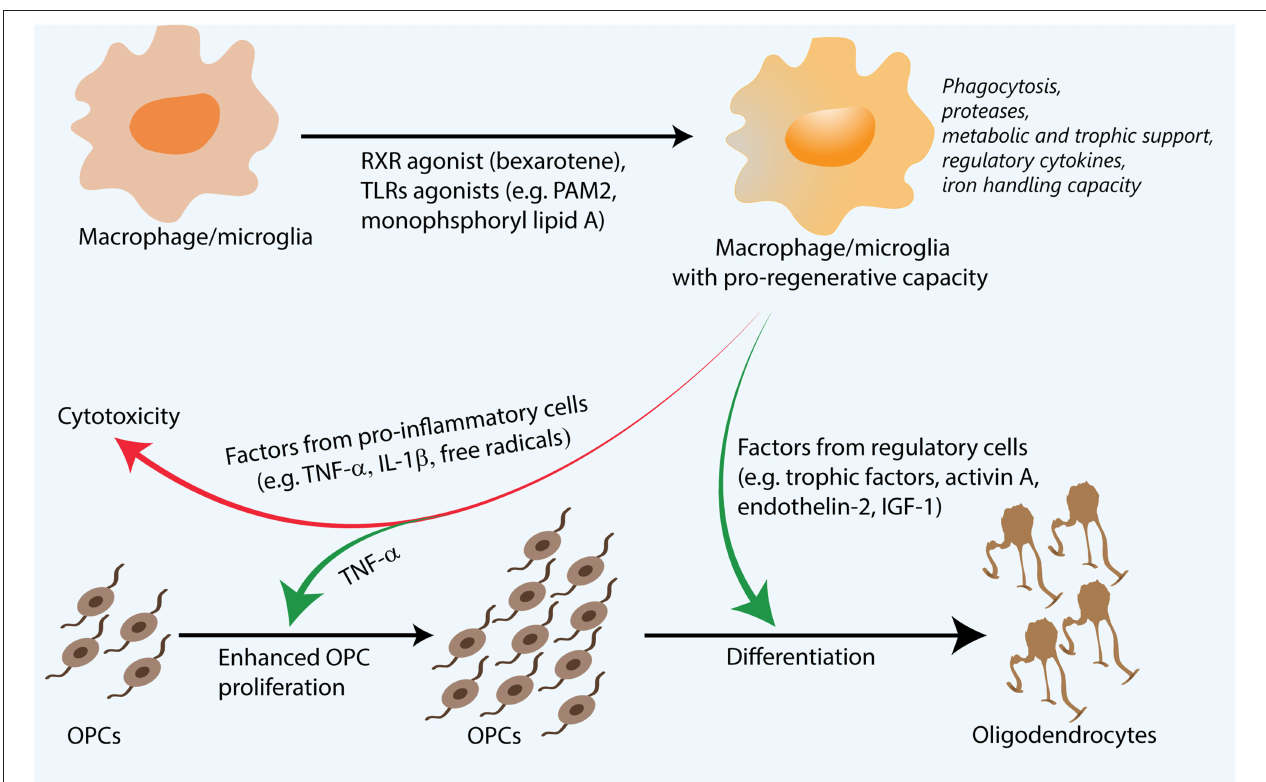
FIGURE 1 | Regenerative macrophages for remyelination. Following their stimulation with agents such as Toll-like receptor (TLR) ligands, retinoid X receptor (RXR) agonists, both pro-inflammatory and regulatory factors are necessary for efficient remyelination. Though pro-inflammatory factors can be toxic to oligodendrocyte precursor cells (OPCs), they are also thought to enhance OPC proliferation. Regulatory factors such as activin A and insulin-like growth factor 1 (IGF-1) are thought to promote OPC differentiation. Additionally, functions such as proteolysis and phagocytosis of inhibitory myelin debris and extracellular matrix molecules, metabolic support through lactate production, as well as iron handling capacity also influence remyelination. Pharmacological approaches that are able to synergistically enhance many of these processes are promising for remyelination and complement existing strategies to directly induce OPC differentiation or neutralize the inhibitory